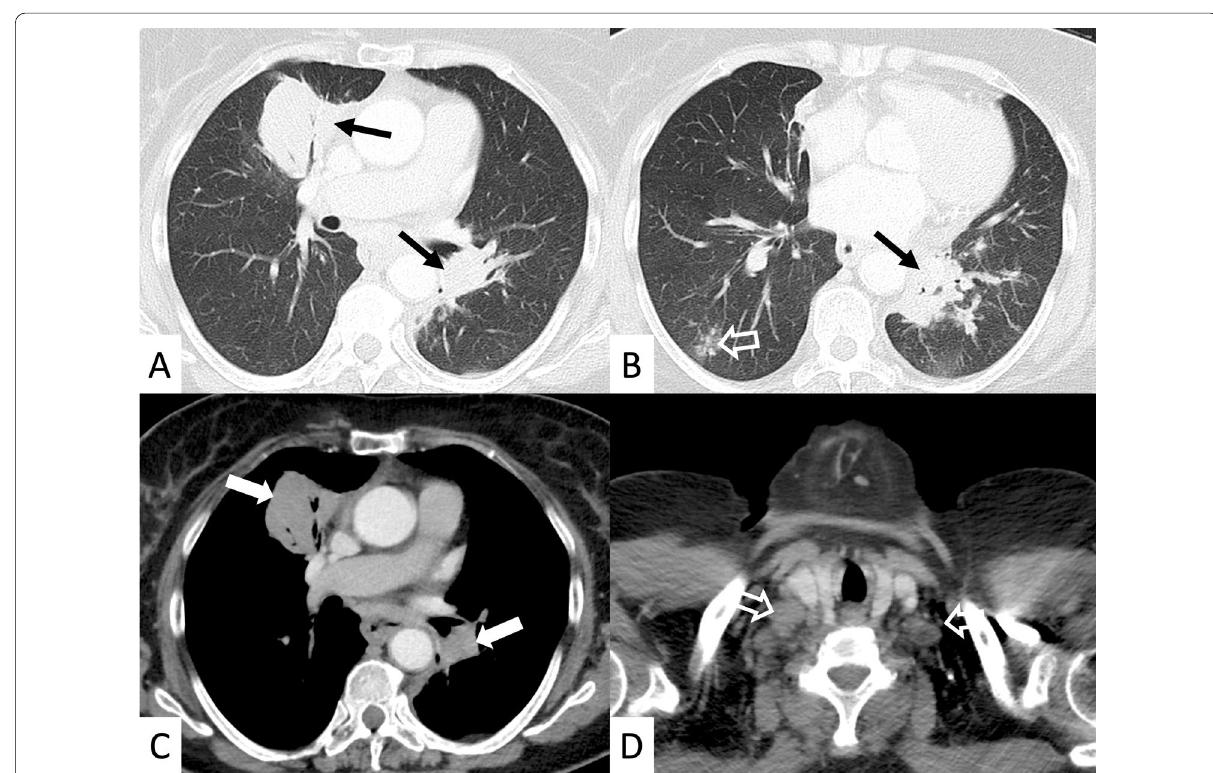
Fig. 28 A 77-old-year female patient affected by SS. After a chest radiograph—which showed pulmonary consolidations—she underwent a CT examination. A , B Right and left pulmonary consolidations are depicted (black arrows in the middle and left lower lobes); B a ground-glass attenuation area, with small nodules, is also demonstrated (empty white arrow). On mediastinal windowing level, the consolidations have homogenous density, appearing as soft attenuation masses (white arrows in C ). A CT scan acquired at the cervical level, clearly demonstrate